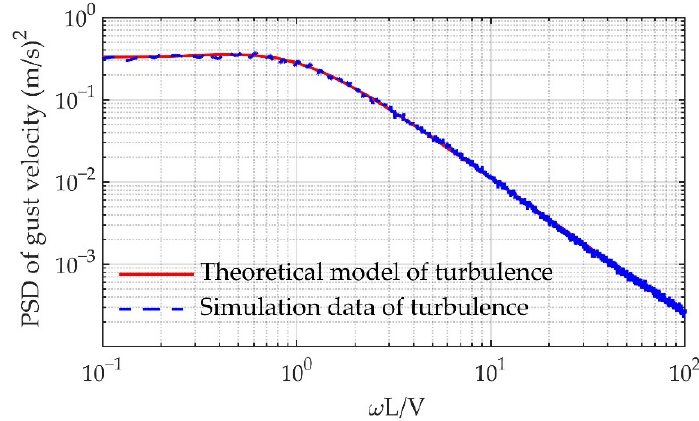
Figure 1. Comparison of PSD of turbulence.